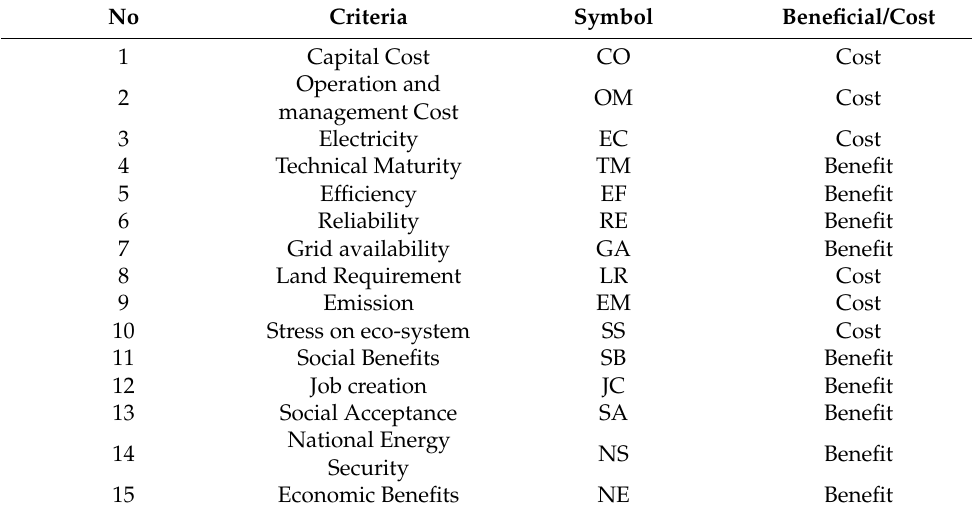
Table 3. All criteria affecting to make decision